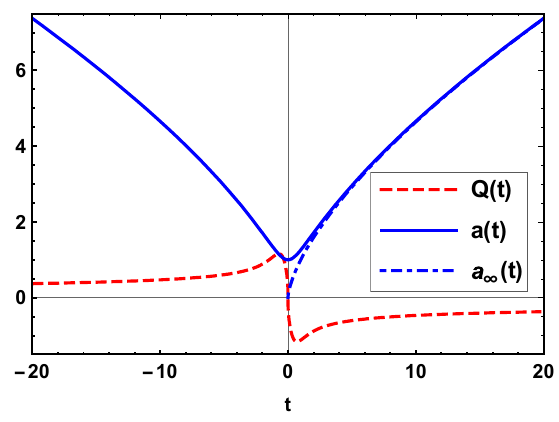
1 3 ( 1 + w ) (solid line) and its corresponding quantum 2 3 ( 1 + w ) (dash-dotted line), which is equivalent